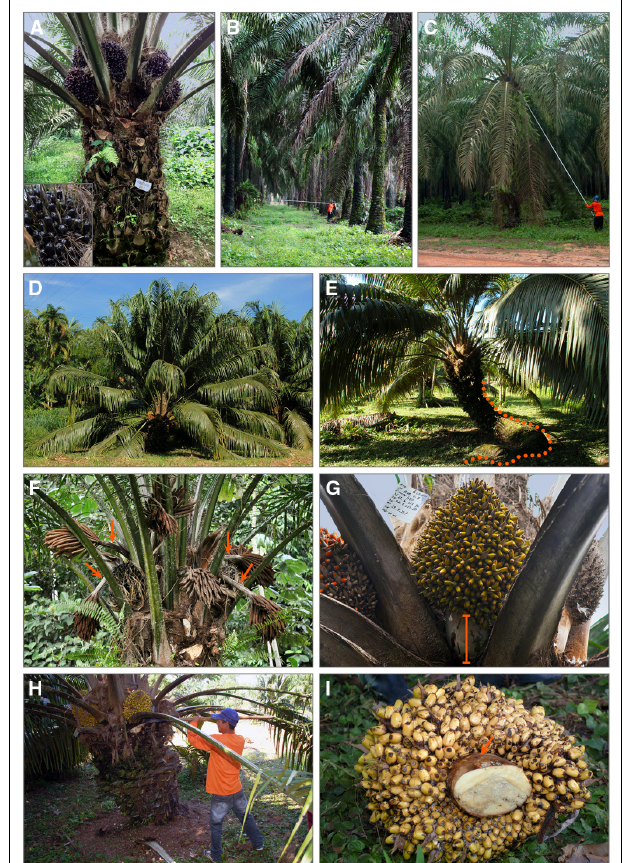
FIGURE 1 | E. guineensis and E. oleifera. (A) Commercial African tenera oil palm from a cross dura Deli (cid:2) pisifera Nigeria. The tree is 5-years-old and has nigrescens fruit type (inset). (B) 26-years-old plantation of tenera palms (Deli (cid:2) Ghana). Trees are 7–8 meters tall. (C) Fruit bunch harvest. A worker is using a knife to cut off bunches from a tree on a plantation shown in (B) . Bunch ripeness is assessed by the presence on the ground of the shed-off fruits. (D) E. oleifera . The wild tree that is more than 30-years-old (Manicoré, Amazonas, Brazil). (E) Walking palm. The same tree as in (D) photographed at different angle to illustrate procumbent trunk that is outlined by the dotted line. (F) African oil palm male inflorescences. This individual has particularly long male inflorescence stalks that are pointed with arrows. (G) Fruit bunch stalk. The 3-months-old fruit bunch of the American oil palm is shown. Bar indicates short stalk. (H) Collection of E. oleifera bunch. Harvesting oil palm requires skilled workers, even when trees are not very tall. (I) Thickness of the bunch stalk. The cut-off bunch from a tree in (H) . Cutting through the bunch stalk (orange arrow) composed of a very fibrous tissue, requires physical